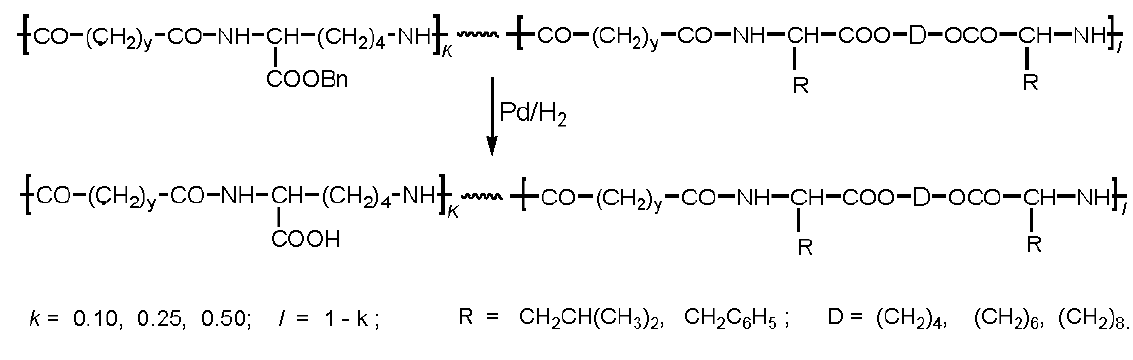
Figure 27. Synthesis of AABBP with lateral carboxyl